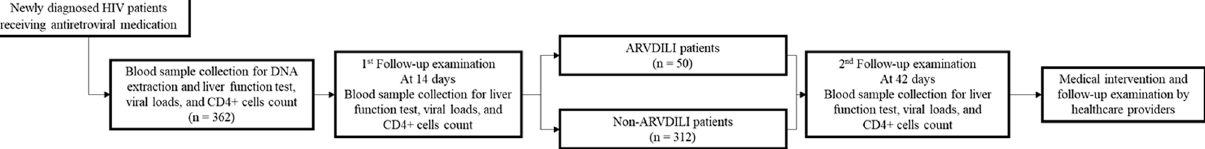
Figure 1. Timeline for patients’ recruiting process. ARVDILI, antiretroviral drug-induced liver injury; HIV, human immunodeficiency virus.